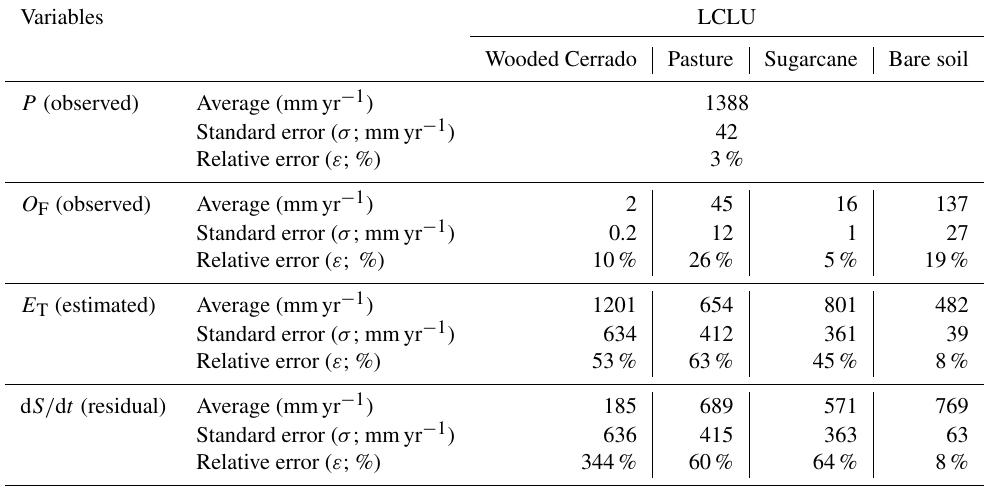
Table 5. Water balance uncertainties. Variables LCLU Wooded Cerrado Pasture Sugarcane Bare